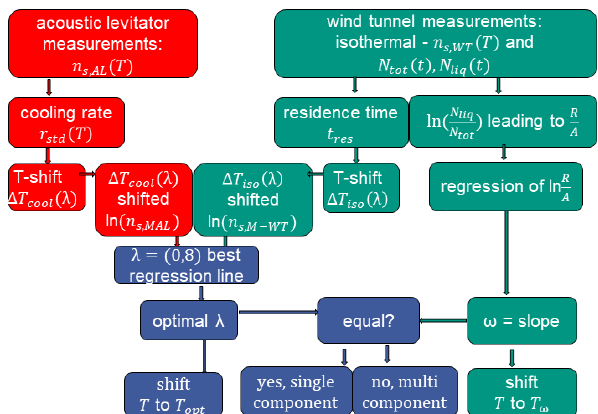
Figure B5. Flowchart of the procedure used to combine M-WT and M-AL measurement data for determining λ and ω and classifying the investigated materials as single- or multiple-component. Red and green boxes correspond to M-Al and M-WT data,